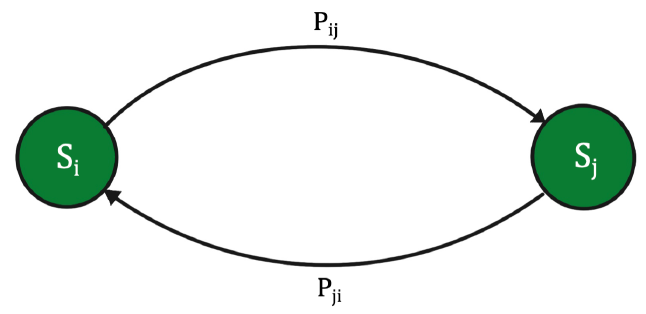
Figure 7. Two State Markov